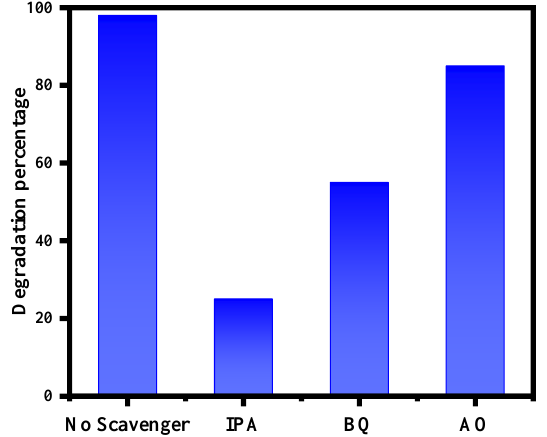
Figure 12. Effect of scavengers on the photocatalytic degradation of MB dye.